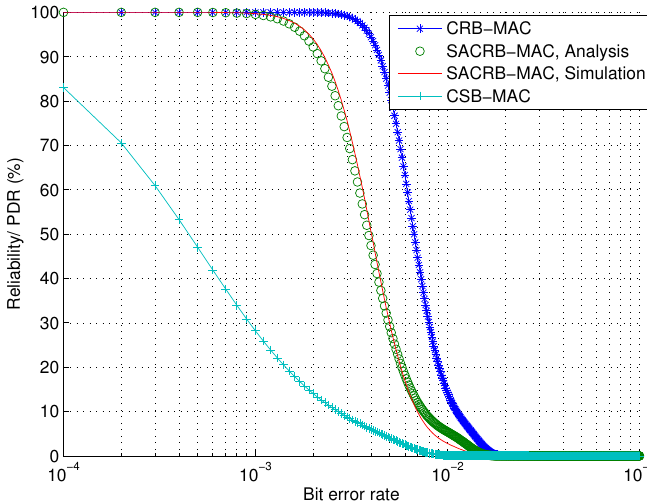
Figure 8. Reliability performance against bit error rate in terms of